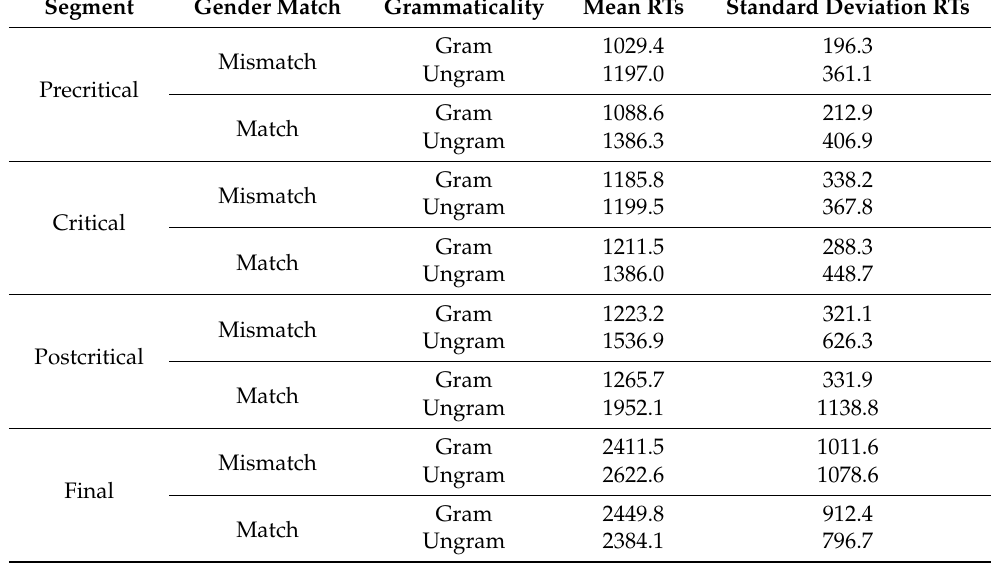
Table A9. Mean raw reaction times and standard deviation for all four sentence types in the precritical, critical, postcritical and final segment for the L1 group, Match: gender match, Mismatch: gender mismatch, Gram: grammatical, Ungram: ungrammatical, RT: reaction